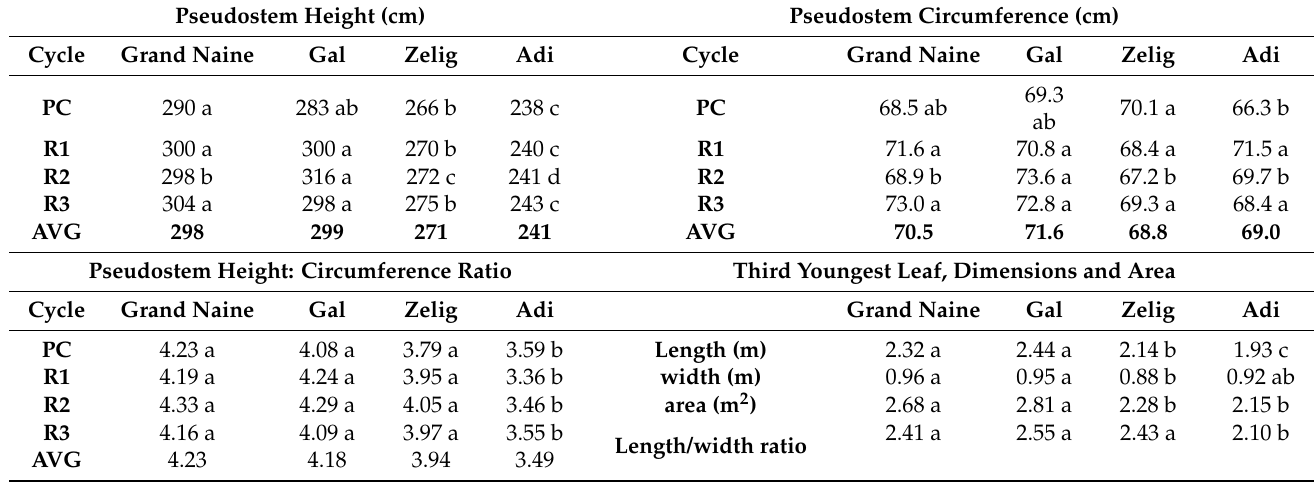
Table 1. Growth parameters for the various cultivars in each crop cycle and average of all cycles ( n = 60 plants/cultivar for pseudostem height and circumference and 10 plants/cultivar for third- youngest leaf dimensions and area). AVG is the mean of the four cycles. Values in a row followed by the same letter are not significantly different ( p >